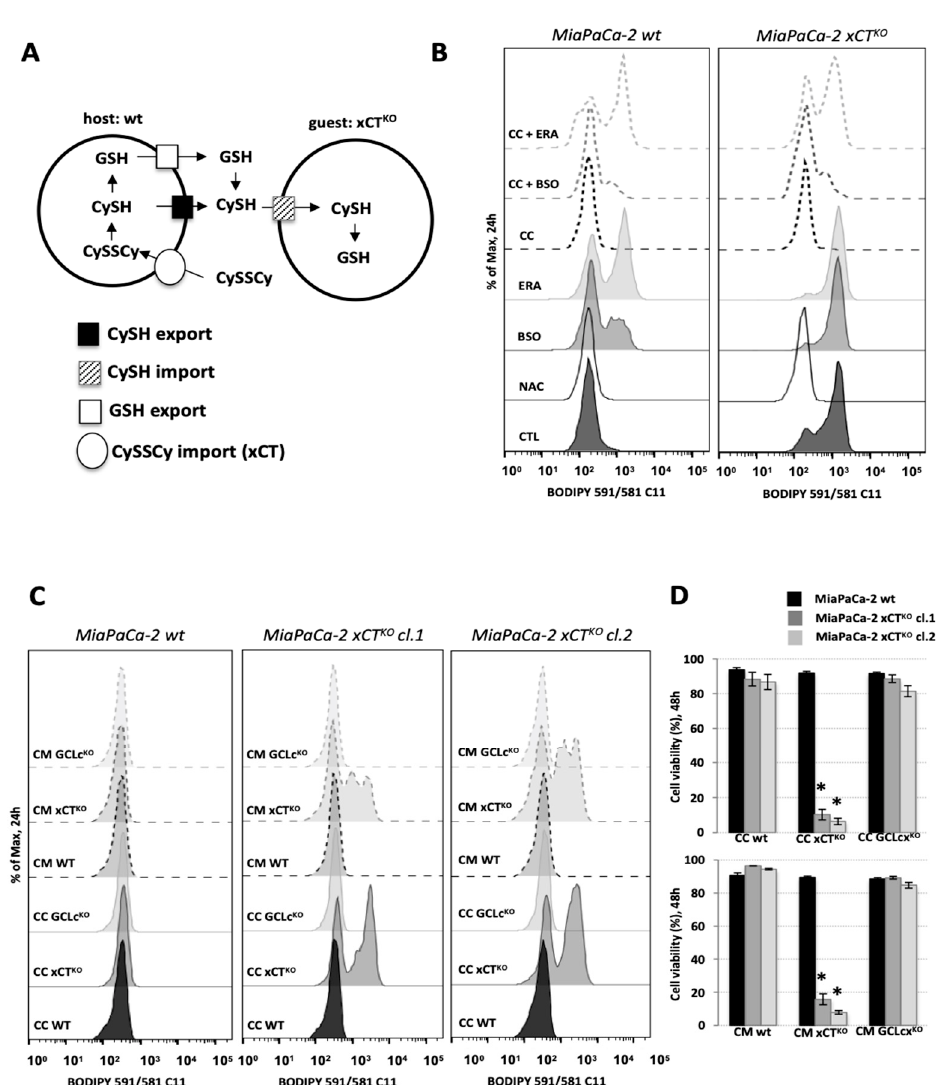
Figure 3. Cystine-cysteine shuttles fuel cooperation between WT and xCT KO cells. ( A ). Schematic representation of the cystine-cysteine (CySSCy, CySH) shuttle: xCT-expressing cells (“host”) are able to import the oxidized form of cysteine, reduce it and export it. Or, in the alternative scenario, the “host” cells can synthesize and export glutathione (GSH), which then will be cleaved outside the cell to the constituent amino acids. Cysteine provided in one or both ways is taken up by the xCT KO cells (“guests”) maintaining the amino acid and redox balance. ( B ). MiaPaCa-2 wt or xCT KO cells alone (full outer lines of the histograms) or in the co-culture with A549 wt (CC—dashed outer lines of the histograms) counterparts in DMEM media +/ − 1 mM N-acetylcysteine (NAC), 100 µ M inhibitor of GSH biosynthesis (buthionine sulphoximine, BSO) or 1 µ M inhibitor of xCT, erastin. ( C ) . Accumulation of lipid hydroperoxides and ( D ). Cell viability of MiaPaCa-2 xCT KO cells in co-culture (CC) or cultivated in the presence of conditional media (CM) of Capan-2 GCLc KO or xCT KO cells during ( C ) 24 h and ( D ) 48 h. All experiments have been performed in triplicate and the representative histograms are shown. Bar graph shows mean ± SEM; n = 3; *, p < 0.05, comparison with WT control